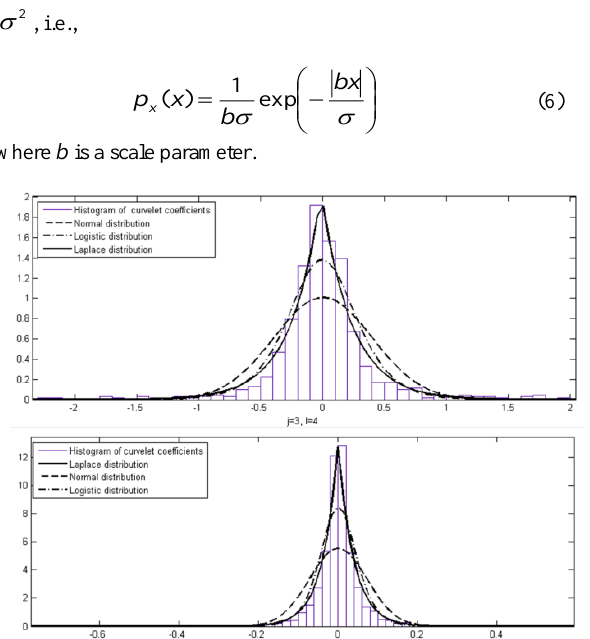
Figure. 1: The histogram of the curvelet coefficients for noise- free data sets (Scale index j and orientation index l ). (Figure. 1) illustrates the histogram of the curvelet coefficients at two different scales and orientations, computed from noise-free images. Compared with Normal and Logistic distributions, it is clear from figure 1 that the Laplacian distribution fits better into